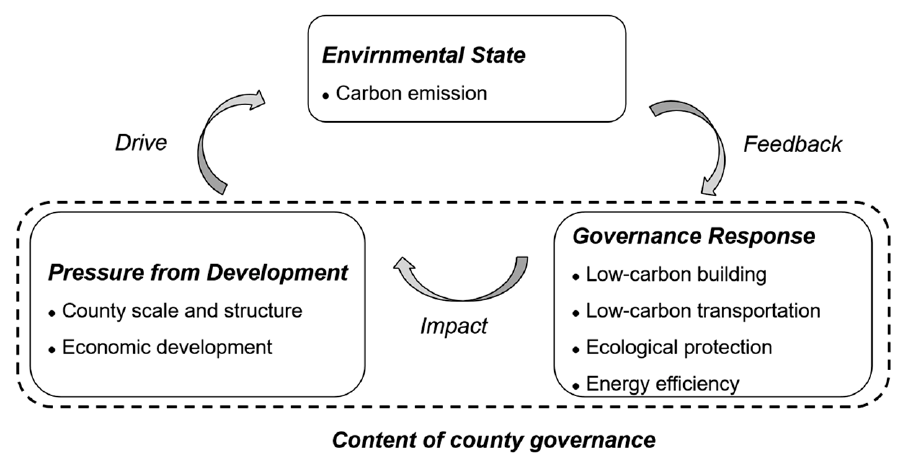
Figure 2. Pressure-state-response (PSR) framework for county-level carbon measurement. By the sorting and classifying of the contents of county governance, as well as the introducing of the governance indicators into the cause-effect chain [56], governance indicators that constituted a causal relationship with carbon emissions were found and formed the initial county-level carbon emission governance indicator system, as shown in Table 1. To ensure that the selected indicators were representative and justified, this study referred to the low-carbon planning indicators in 15 typical papers on low-carbon city indicator systems [7,49,57–69]. The initial indicators’ reference rates in the 15 references were counted and most were higher than 30%. In addition, the indicator of total investment in fixed assets, which reflects the reproduction of fixed assets in the county governance content, was added to economic development. Combined with the indicator of the density of heating pipelines, the indicator of the floor-area ratio of heating was added to the low-carbon building sector in order to reflect building heating in both the density and intensity